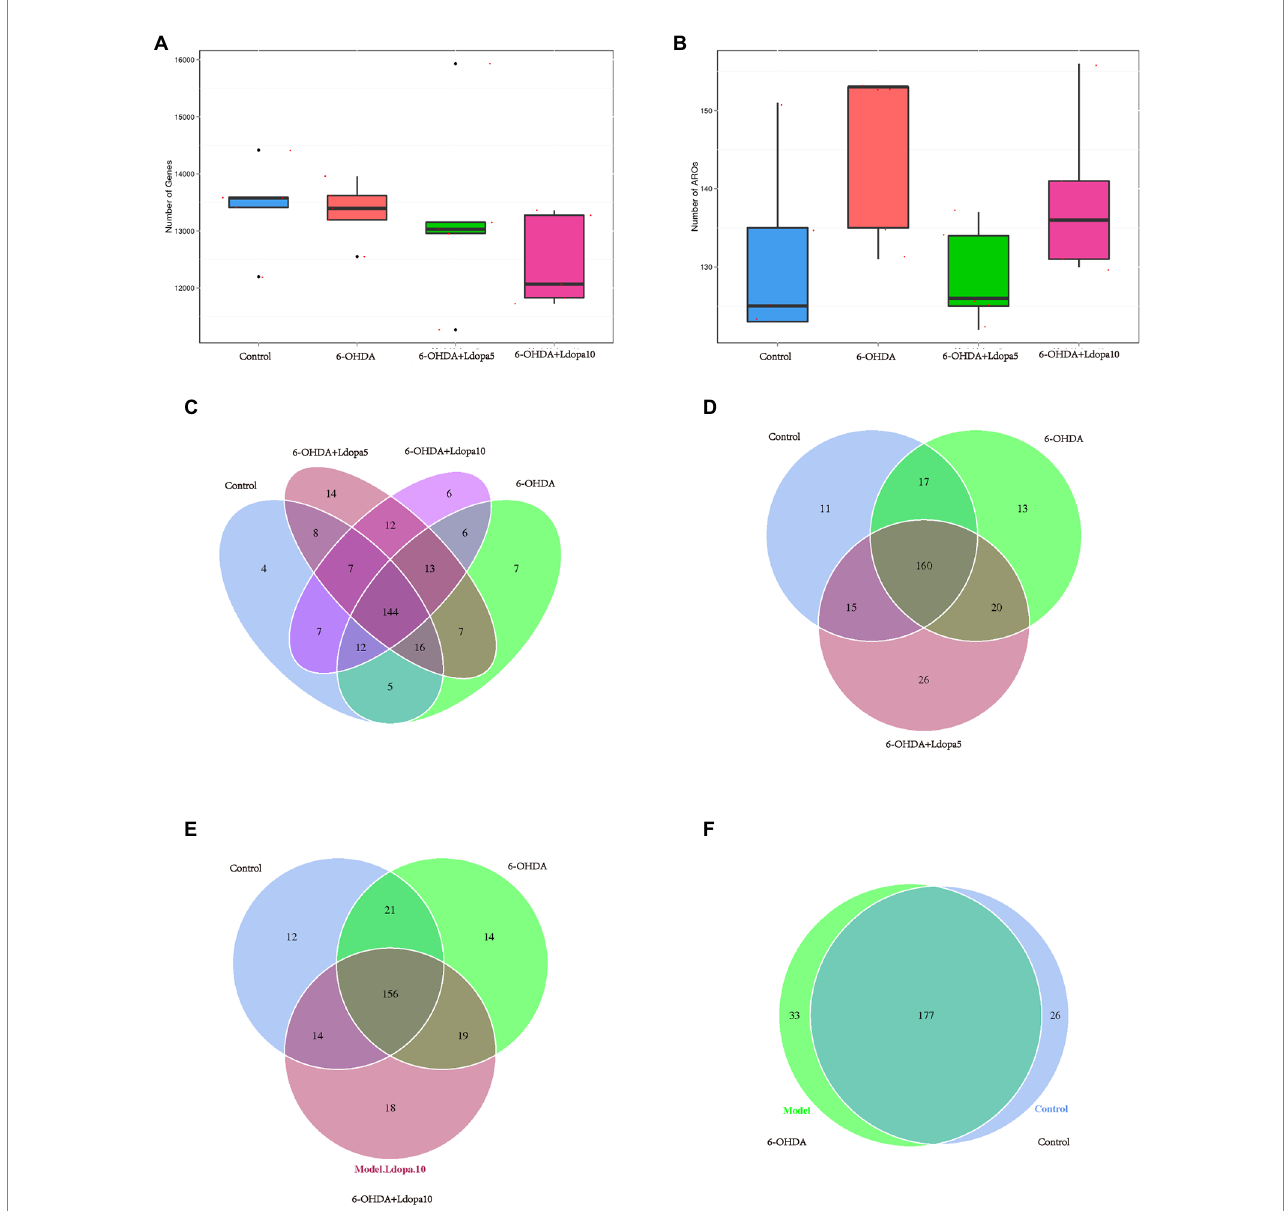
FIGURE 5 Antibiotic resistance genes shared among the four groups. (A) Number of antibiotic resistance genes in control, 6-OHDA, 6-OHDA+Ldopa5 and 6-OHDA+Ldopa10 groups is shown. (B) Number of ARO in control, 6-OHDA, 6-OHDA+Ldopa5 and 6-OHDA+Ldopa10 groups was indicated. (C–F) Each circle represents a group in the Venn diagram, the number of overlapped parts represent the number of resistance genes shared among groups, and the number without overlap represent the number of specific resistance genes in the